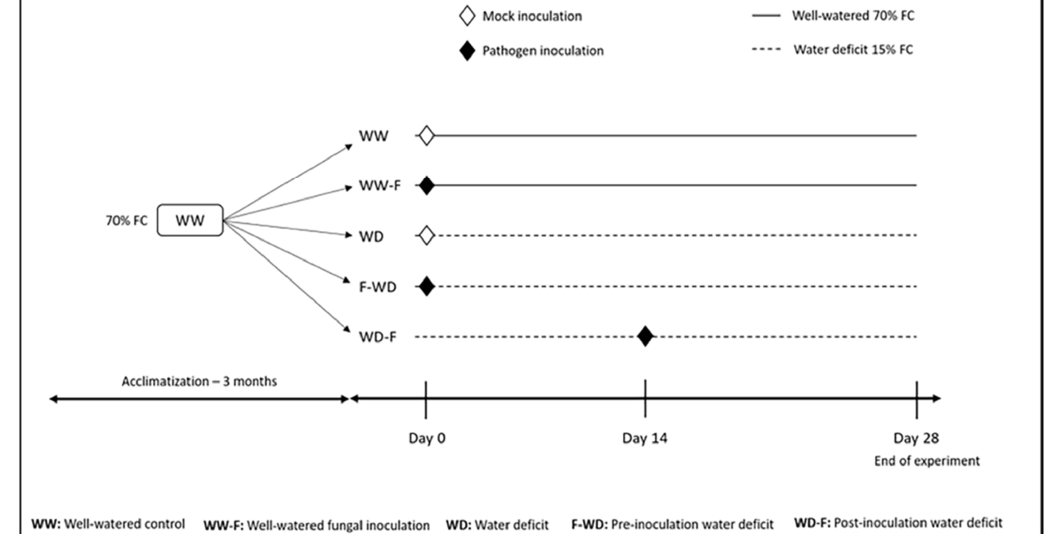
Figure 7. Schematic illustration of the experimental design. Water Deficit Treatment